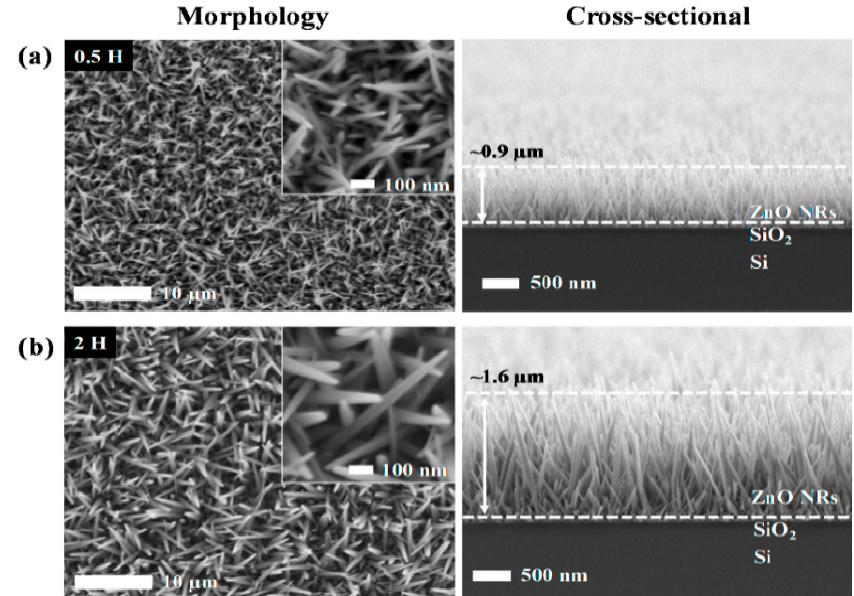
Figure 15. SEM images of top and cross-sectional views of ZnO nanorods formed on ZnO-seeded SiO 2 / Si substrate by immersing in zinc acetylacetonate hydrate and HMTA solution for ( a ) 0.5 h and ( b ) 2 h. Insets in left panels of ( a , b ): High-magnification plan-view SEM images. Right panels: cross-sectional SEM micrographs. Reproduced from [223] under the terms of the Creative Commons Attribution License (CC BY).